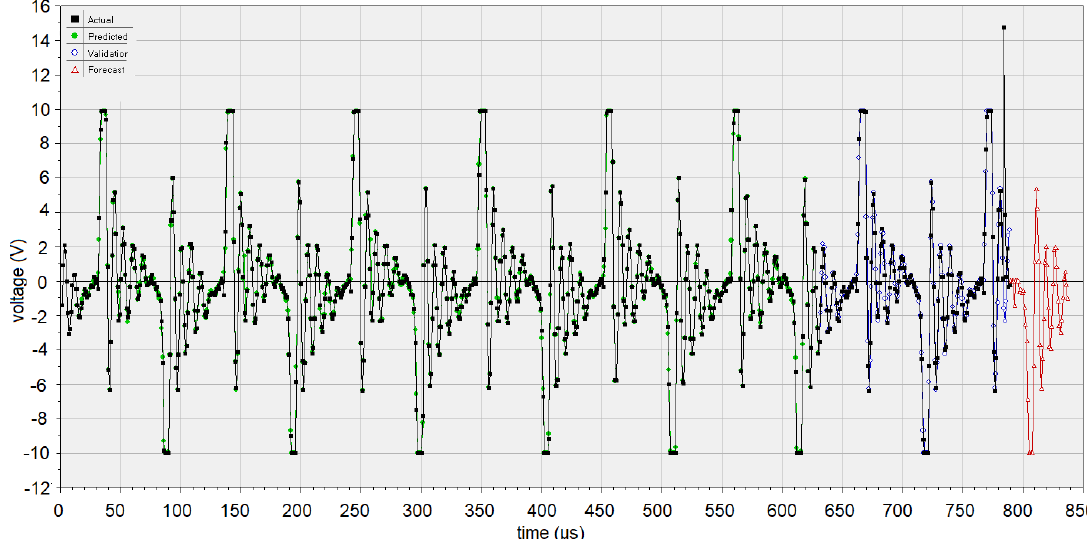
Figure 8. GRNN model. The Actual (recorded data), Predicted (computed values on the training set), Validation (computed values on the test set), and Forecast (the new data series built using the GRNN model) sets (obtained using the DTREG software).